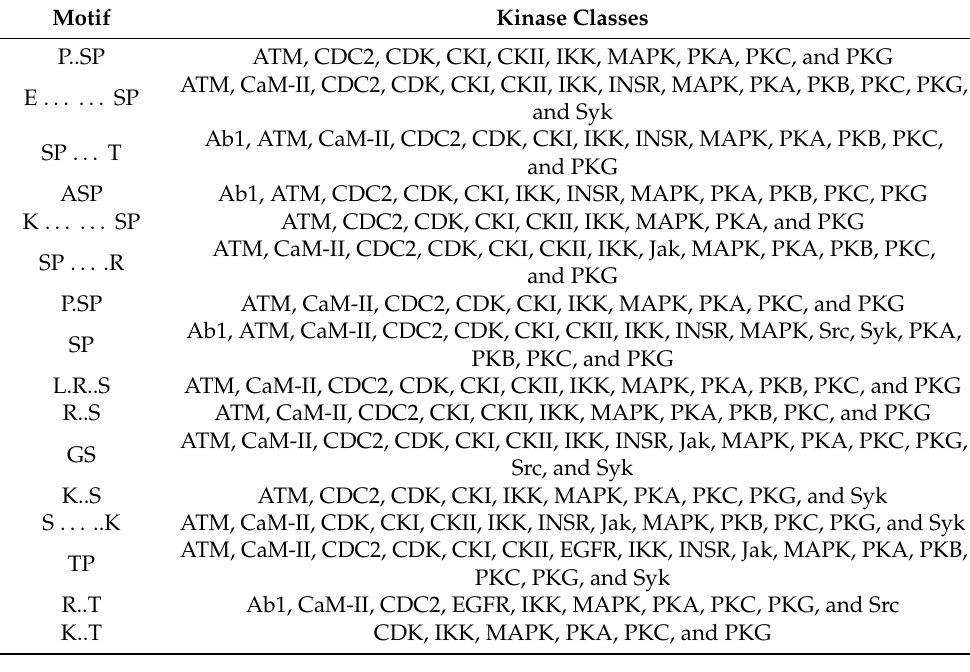
Table 1. Recording of the kinase types corresponding to the motifs of upregulated phosphorylated peptides, as identified using KinasePhos.